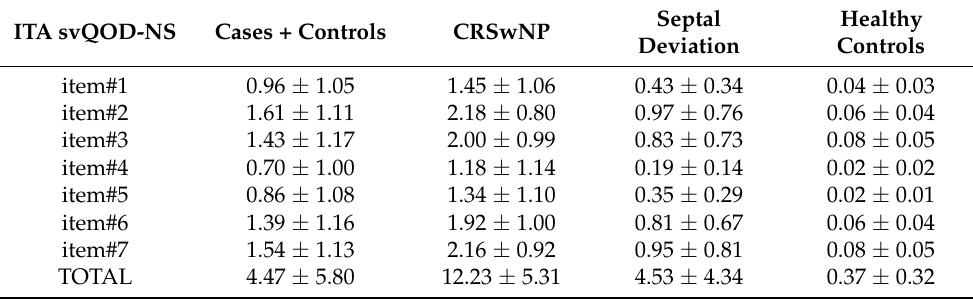
Table 4. Mean scores for each item (range: 0–3) and total score (range: 0–21) of the ITA svQOD-NS. In each cell, mean value ± standard deviation are reported.